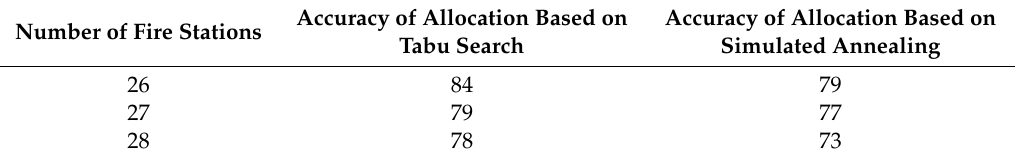
Table 24. Comparison of the accuracy of allocation results.